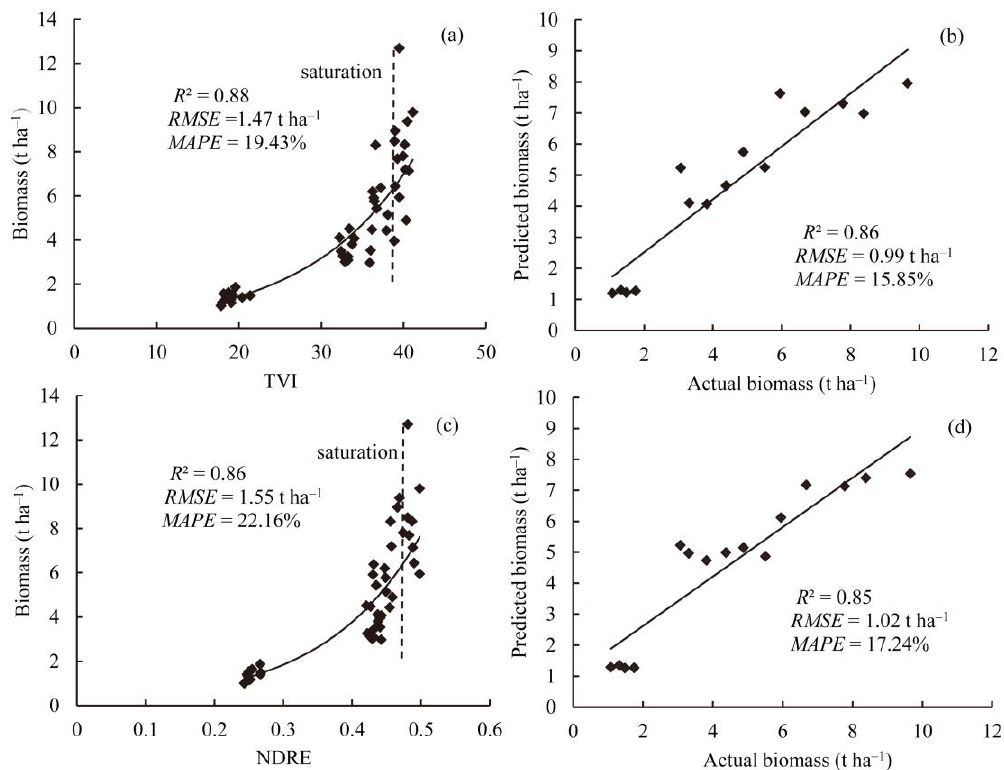
Figure 4. Results when using the triangular vegetation index (TVI) and normalized difference red (NDRE) indices to estimate the biomass. ( a ) Calibration results for TVI, ( b ) validation results for TVI, ( c ) calibration results for NDRE, and ( d ) validation results for NDRE.